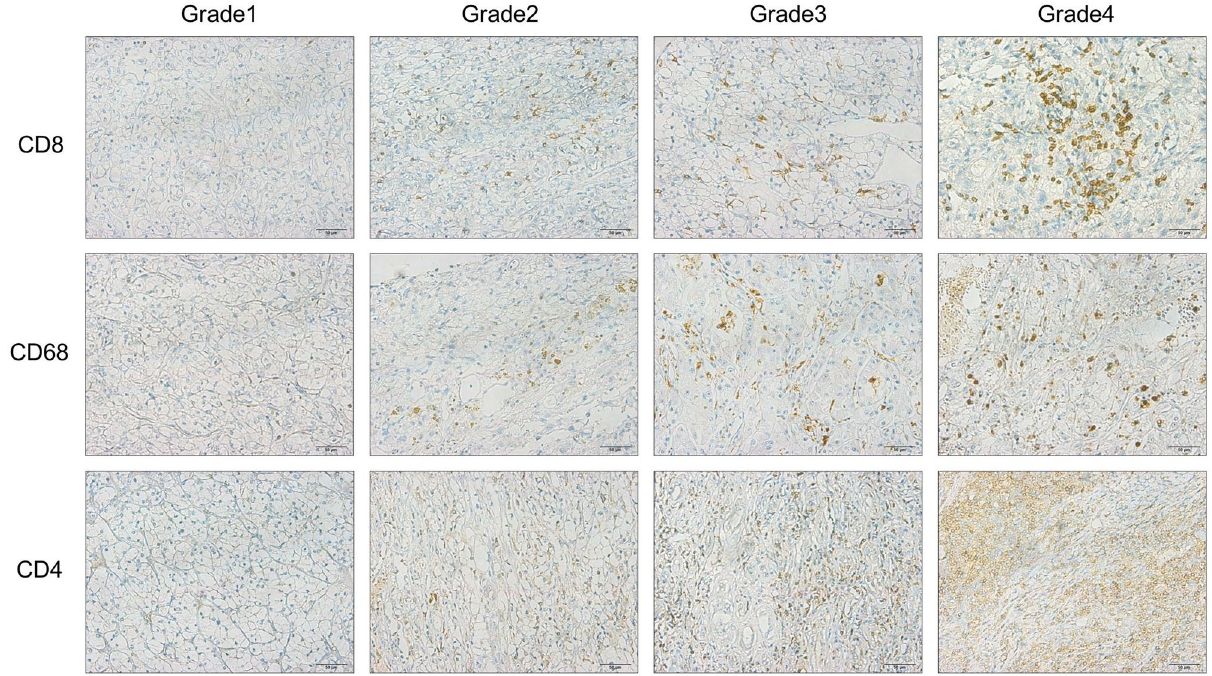
Figure 2. Representative immunohistochemical staining of CD8, CD68, and CD4 in tumor tissue obtained from RCC patients. All IHC Staining was defined as Grade1 when all tumor infiltrated cells were negative or no cancer cell was stained, Grade2 when staining was weakly positive, Grade3 when staining was moderately positive, and Grade4 when staining was strongly positive. Magnification is × 200 and × 400. Scale bar shows 100 μm and 50 µm,